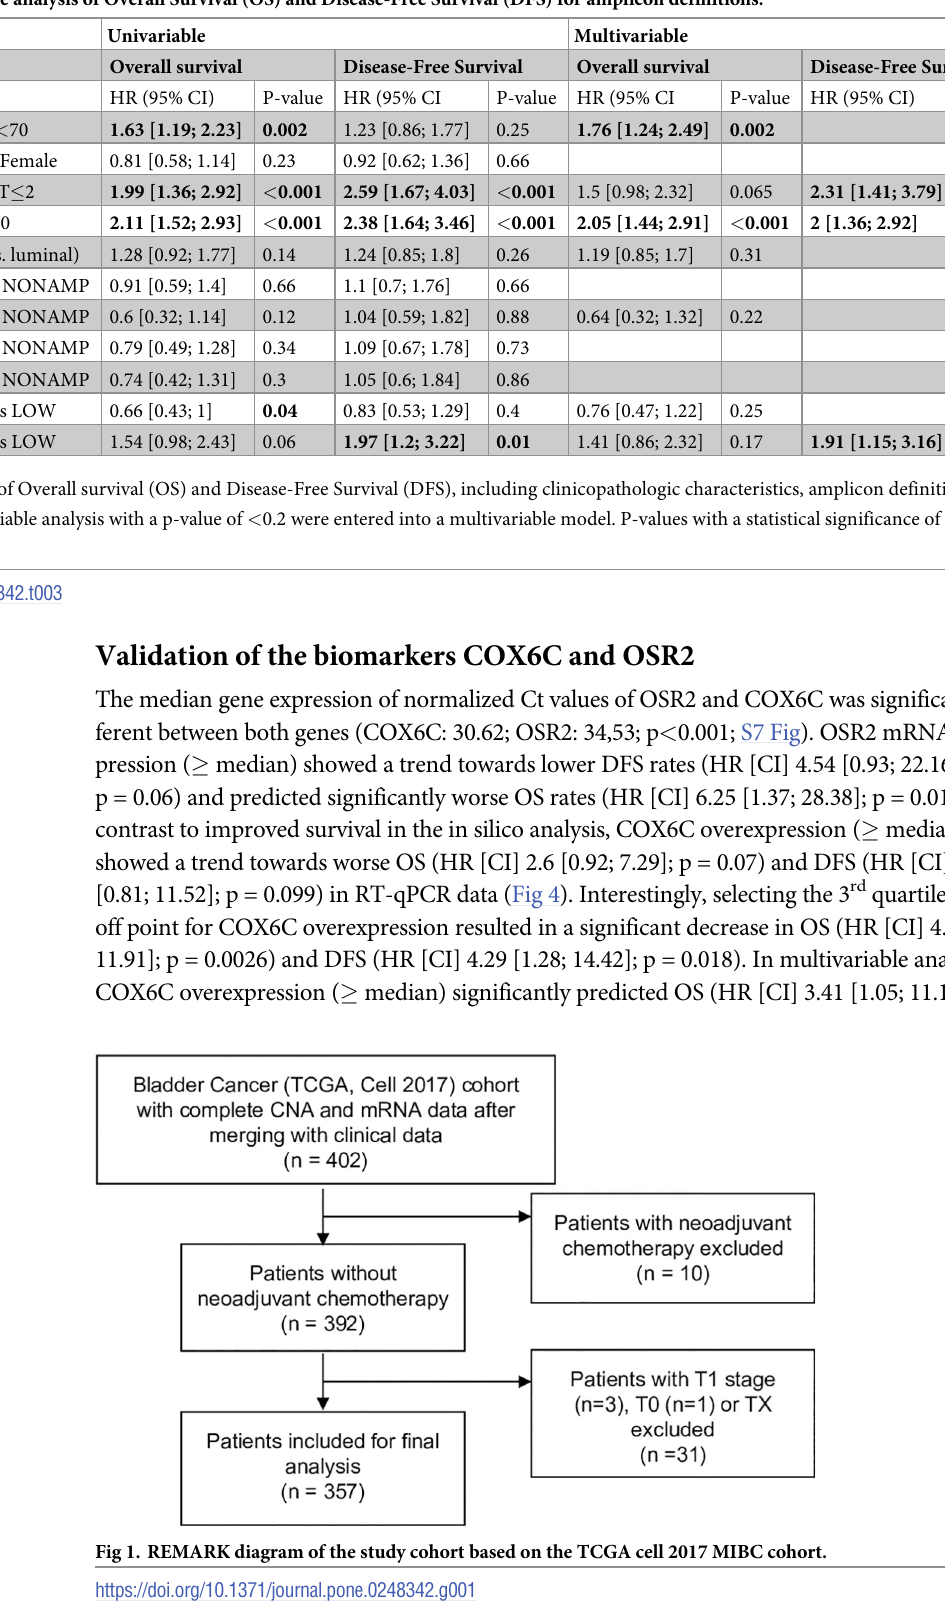
Table 3. Univariable and multivariable analysis of Overall Survival (OS) and Disease-Free Survival (DFS) for amplicon definitions. Clinicopathologic variables